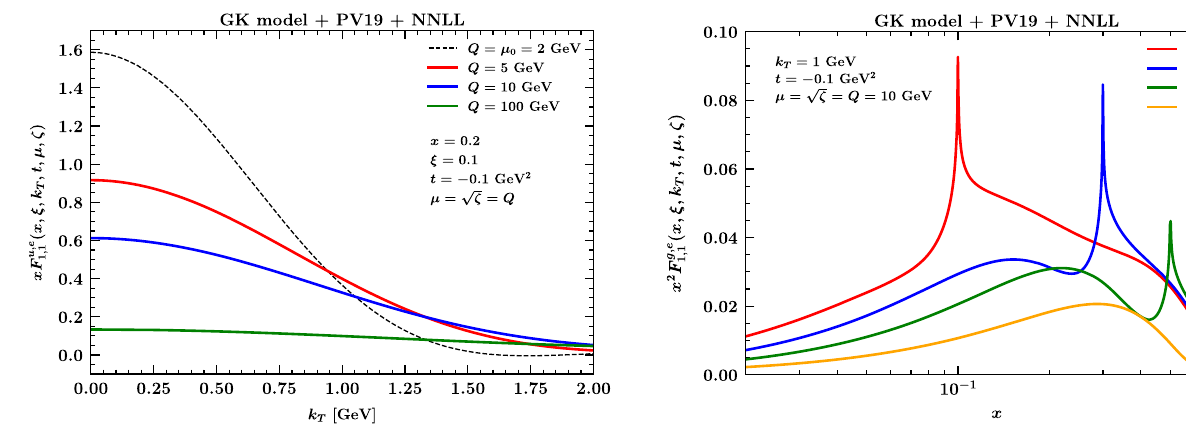
, e Fig. 6 x 2 F g (gluon) vs x at k T = 1 GeV, t = − 0 . 1 GeV 2 , and Fig. 4 xF u , e (upquark)vs k T at x = 0 . 2, ξ = 0 . 1,and t = − 0 . 1GeV 2 √ 1 , 1 √ 1 , 1 ζ = 10 GeV for four different values of the skewness: Q = μ = ζ : Q = 2 GeV for four different values of the hard scale Q = μ = ξ = 0 . 1 (red curve), ξ = 0 . 3 (blue curve), ξ = 0 . 5 (green curve), and (blacked dashed curve, GPD model at the initial scale μ 0 ), Q = 5 GeV ξ = 0 . 7 (orange curve). F g , e is computed at NNLL accuracy (see text) (solid red curve), Q = 10 GeV (solid blue curve), and Q = 100 GeV 1 , 1 using the GK model for the GPDs and the PV19 determination for the (solid green curve). F u , e is computed at NNLL accuracy (see text) 1 , 1 non-perturbative transverse using the GK model for the GPDs and the PV19 determination for the non-perturbative transverse component